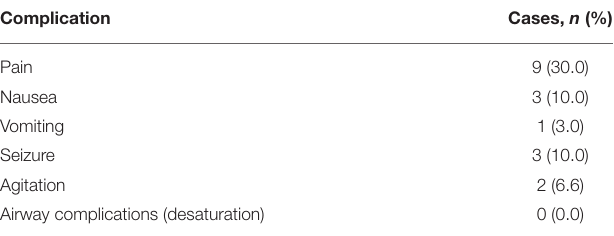
TABLE 2 | Incidence of intraoperative